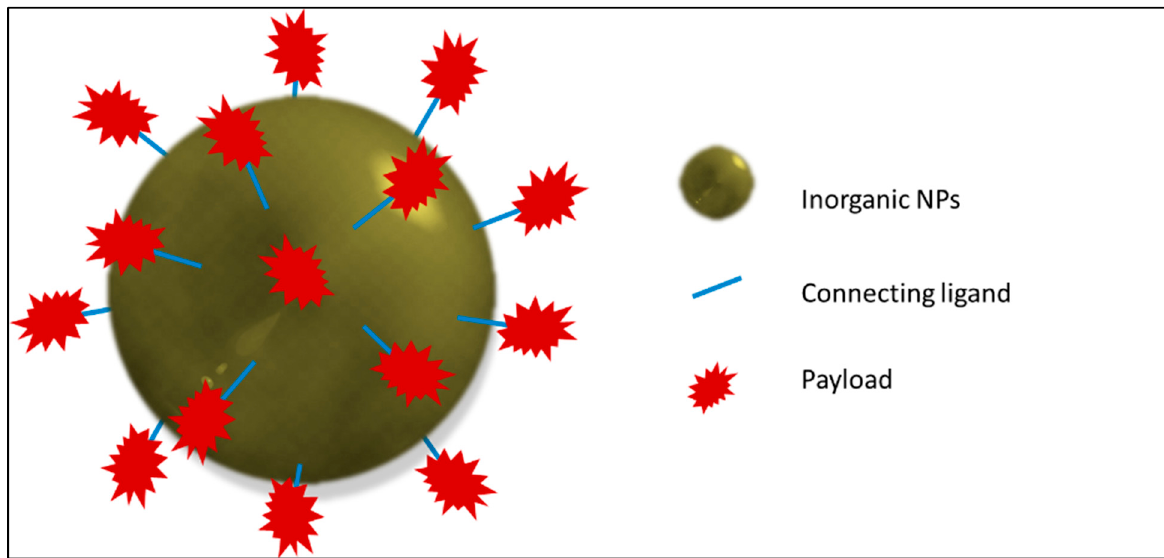
Figure 8. General representation of inorganic NPs where payloads (red star) are attached to the surface of the nanosystem. They include gold, silica, iron oxide, quantum dots, nanotubes